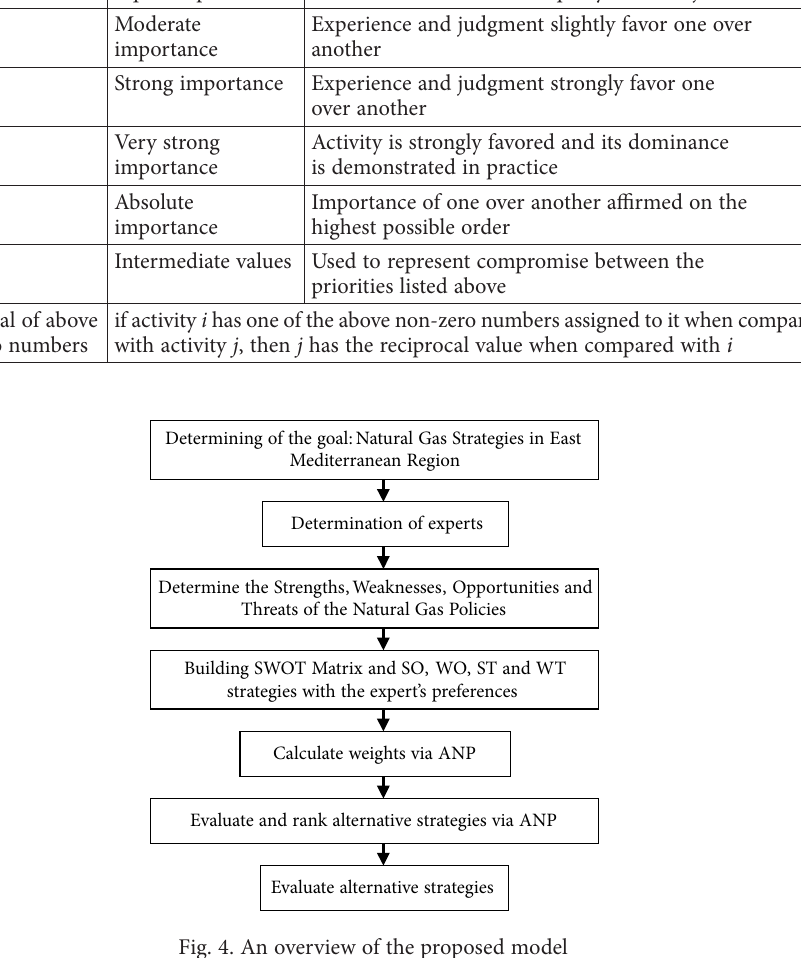
Fig. 4. An overview of the proposed